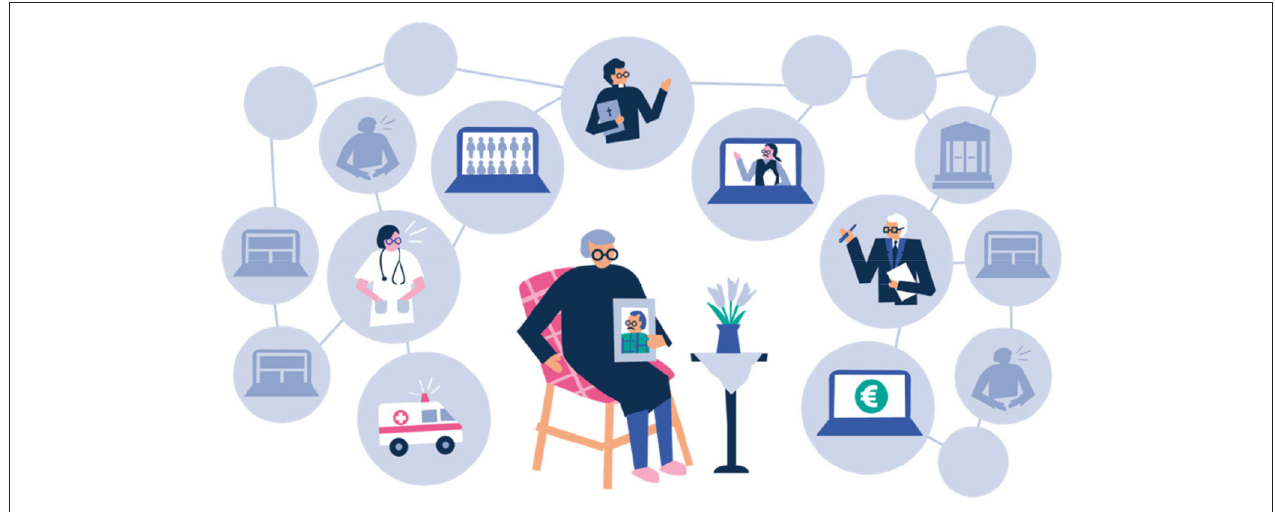
FIGURE 1 | The AuroraAI program will support citizens throughout their life events (Ministry of Finance).